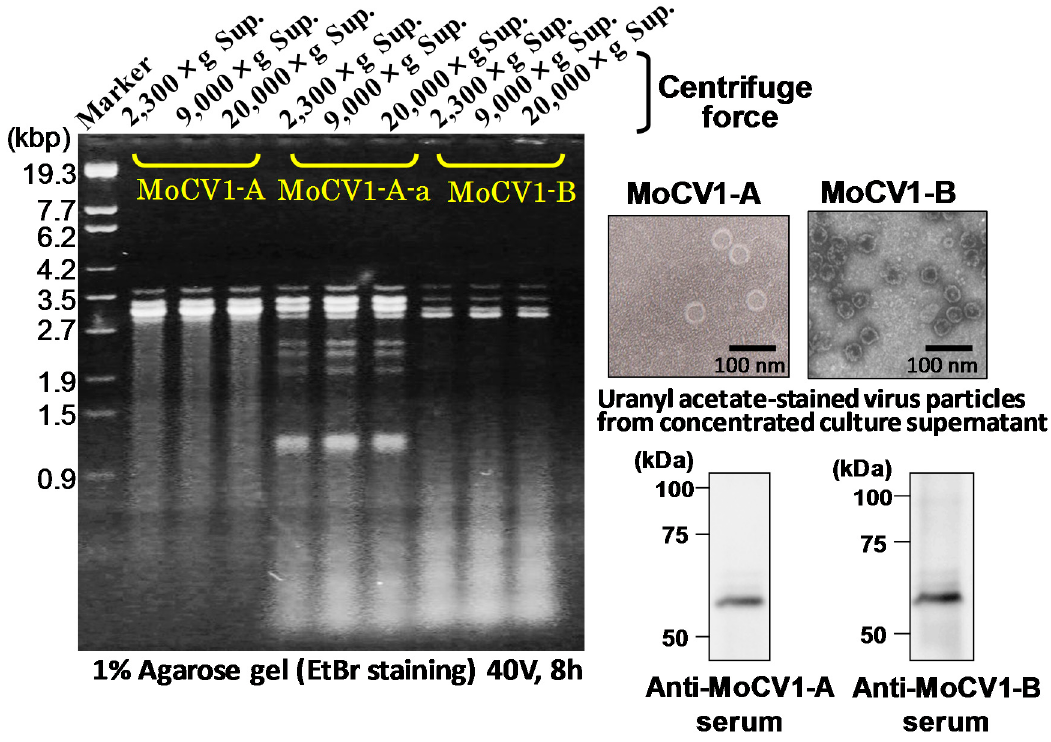
Figure 7. Release of mycoviruses from the mycelium of mycovirus-infected M. oryzae into the culture supernatant. The mycoviruses gradually appeared and accumulated in the liquid medium during the long-term suspension culture. After five weeks of liquid culture, 250 µ L samples of the culture supernatant were subjected to stepwise centrifugation treatments. Total nucleic acids were extracted from each supernatant and then subjected to agarose gel electrophoresis.